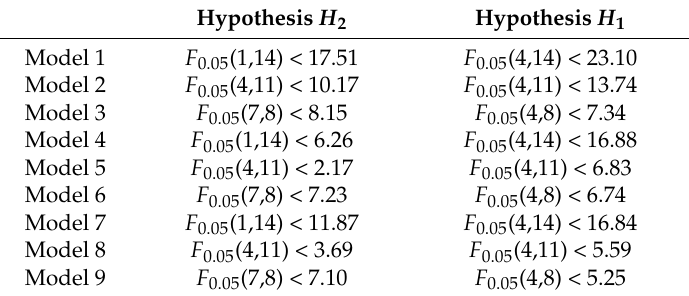
Table 5. F -test results.